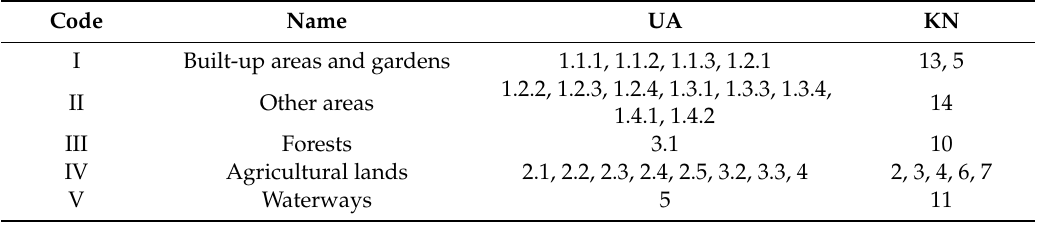
Table 5. The composition of the new nomenclature (aggregated nomenclature) from the original classes. Code